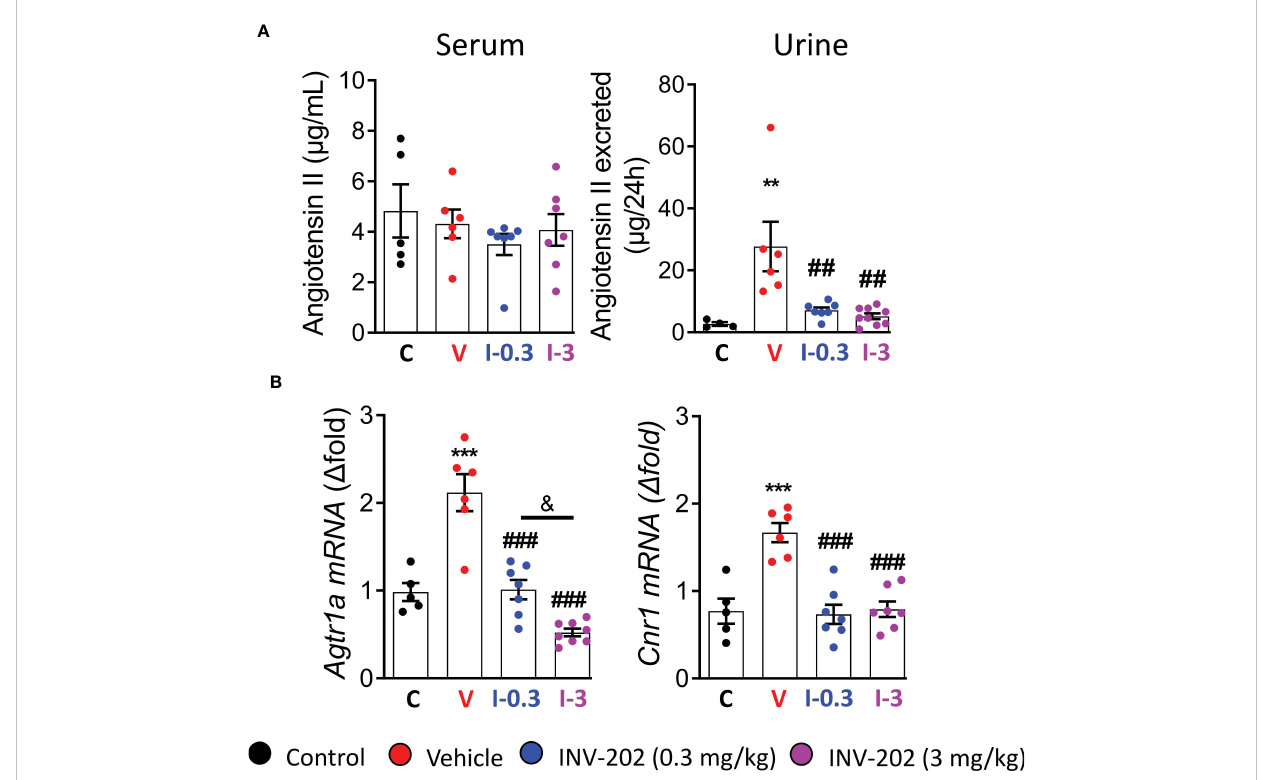
FIGURE 3 INV-202 treatment effects on angiotensin II excretion. (A) Serum and urinary angiotensin II concentration. (B) Agtr1a and Cnr1 mRNA expression that codes for the angiotensin II receptor and the cannabinoid 1 receptor, respectively. Statistical signi fi cance versus nondiabetic control: **p <